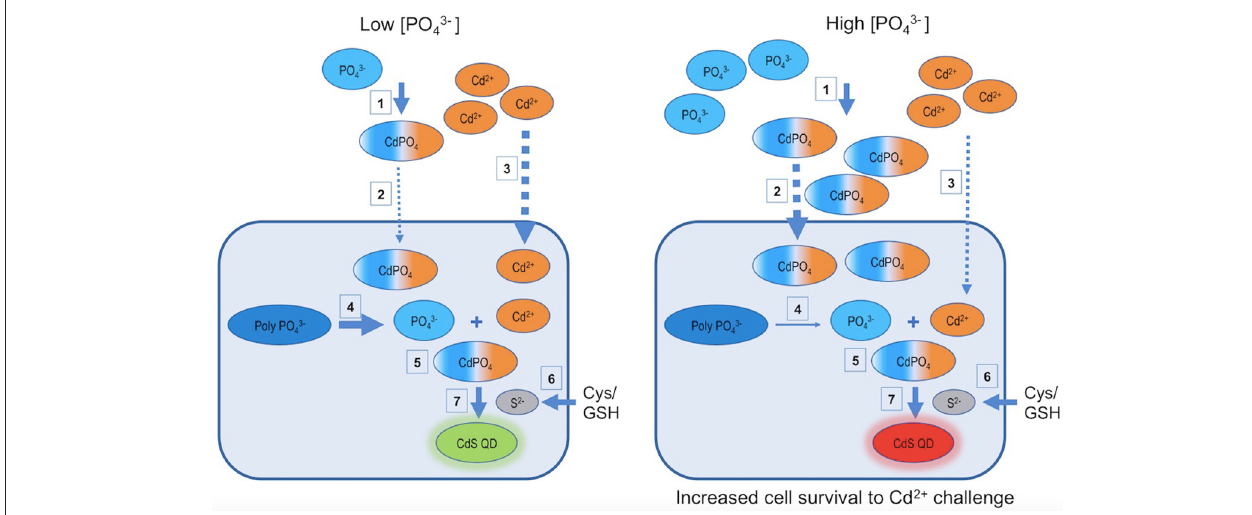
FIGURE 5 | Models for phosphate dependent CdS-QDs biosynthesis by A. thiooxidans ATCC 19703. Based on the results of the present work, two models describing the phosphate dependent CdS QDs biosynthesis process at low and high PO 3 − 4 concentrations are proposed. GSH, glutathione; Cys, cysteine; PolyPO 3 − 4 , polyphosphates; CdPO 4 , cadmium phosphate